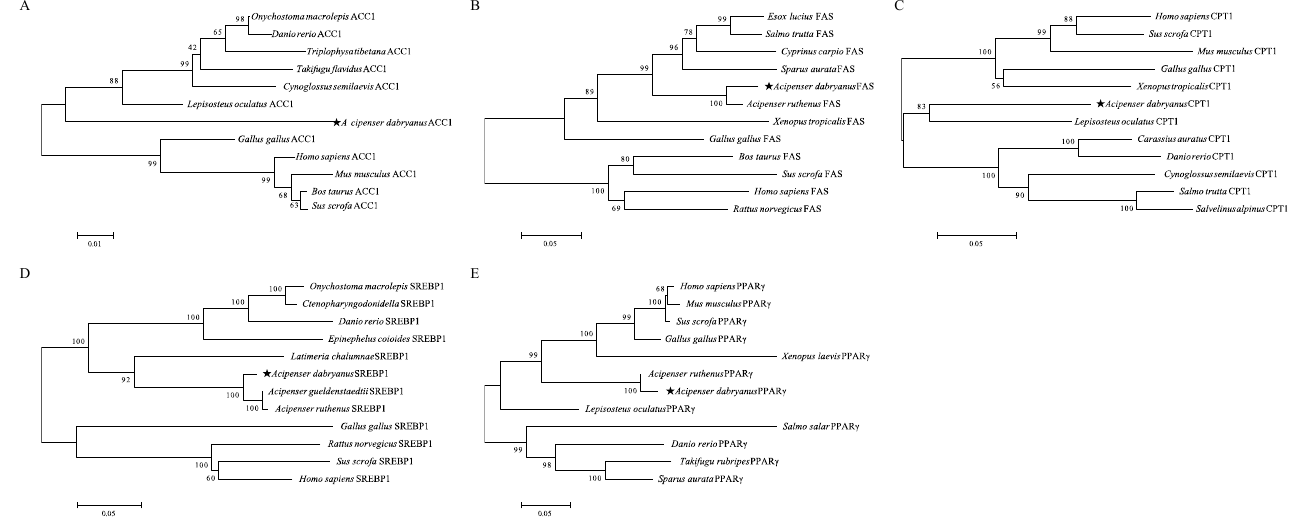
Figure 7. Phylogenetic trees of ( A ) ACC1 , ( B ) FAS , ( C ) CPT1 , ( D ) SREBP , and ( E ) PPAR γ ammonia acid sequences in Yangtze sturgeons. Numbers at nodes indicate the boot-strap values, as percentages, obtained for 1000 replicates. Yangtze sturgeon is marked with a pentagram ( ★) .